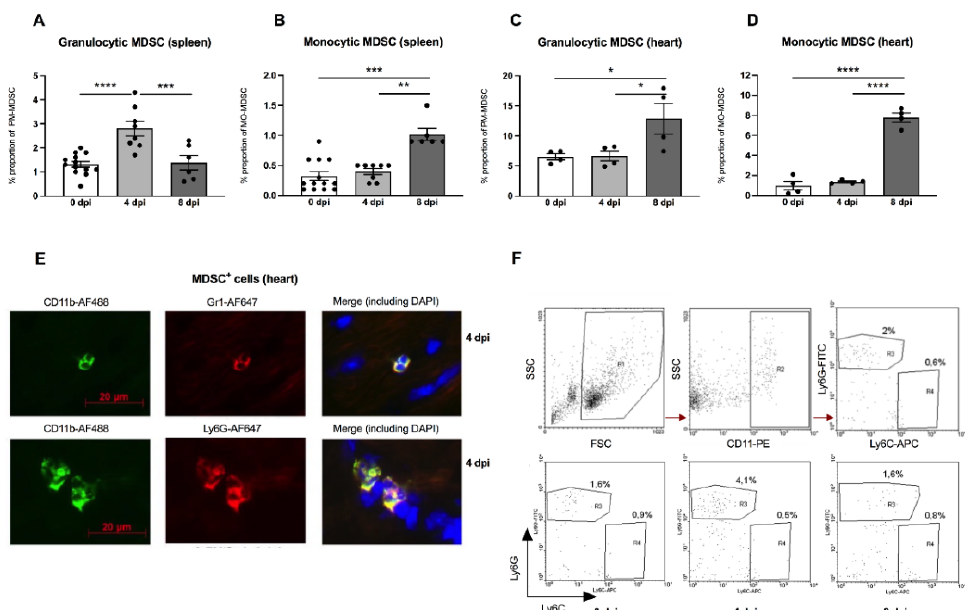
Figure 1. Granulocytic and monocytic MDSC subpopulations are increased in the spleen and heart of CVB3-infected A.BY/SnJ mice. Isolated splenic and cardiac immune cells were selected based on CD11b + Ly6G high Ly6C low (granulocytic MDSC; ( A , C )) and on CD11b + Ly6G low Ly6C high (monocytic MDSC; ( B , D )). The y-axis displays the percentual proportion of 50,000 and 20,000 measured splenic or cardiac cells, respectively. The panel below ( E ) shows representative immunofluorescence pictures of cardiac tissue 4 days post infection (dpi) stained with anti-CD11b-AF488, anti-Gr1-AF647 (monocytic), anti-Ly6G-AF647 (granulocytic), and DAPI. Representative images of flow cytometry of the spleen from naive mice (upper panel) and from mice 0 dpi, 4 dpi, 8 dpi CVB3 (lower panel) are shown in ( F ). The gating strategy is depicted as R1 = vital cells, R2= CD11b + cells, R3 = Ly6Ghigh granulocytic MDSC, R4= monocytic MDSC. Data are expressed as mean ± SEM and were analyzed with One-way ANOVA or Kruskal-Wallis test (* p < 0.05, ** p < 0.01, *** p < 0.001, **** p < 0.0001 with n = 13 for 0 dpi, n = 8 for 4 dpi, and n = 6 for 8 dpi for the splenic immune cells ( A , B ) and n = 4/group for the cardiac immune cells ( C , D )).